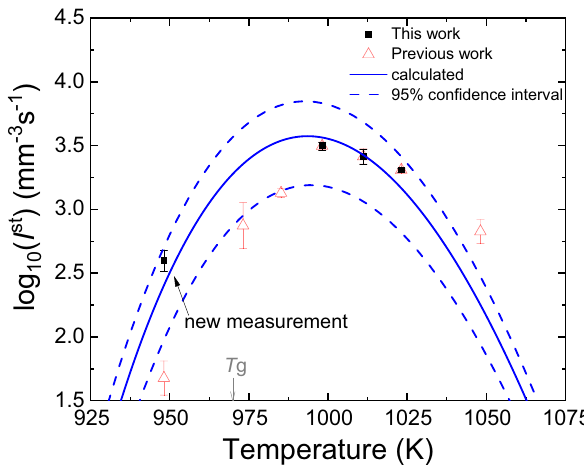
Fig. 4 A comparison between the calculated steady-state nucleation rate from the Classical Nucleation Theory and the measured data. The solid blue curve is the calculated rate from theory. The red symbols represent the values obtained in the previous study 10 . The dashed lines are the 95% con fi dence limits for the calculated curve. The error bars are the 95% con fi dence intervals of the measured data. T g is the glass transition